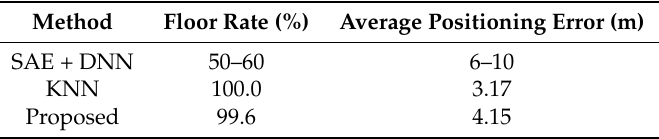
Table 4. Experimentation results for options